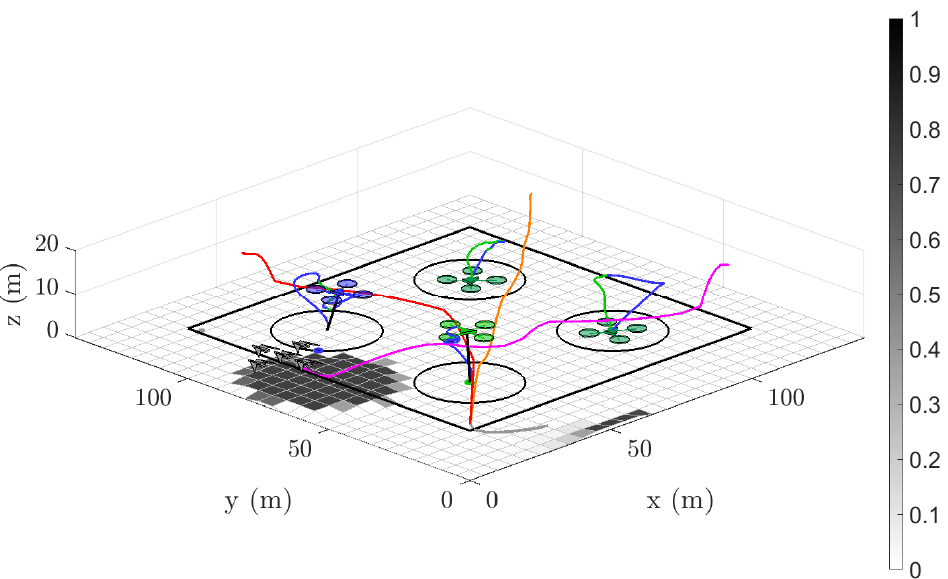
Figure A6. Triple-target scenarios—sample simulation 3D trajectory by 𝑡 = 56 s, for all three target flocks. Regions of maximum energy expenditure correlate to high acceleration areas such as take-offs and landings.